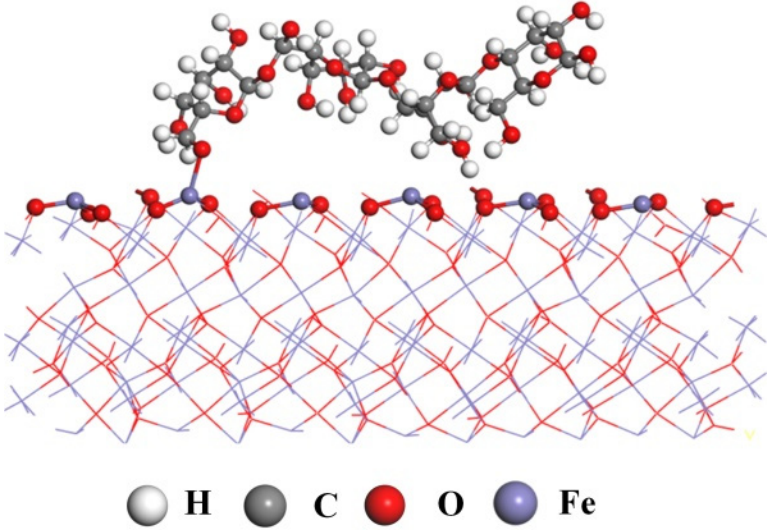
Figure 11. The pullulan adsorption model on hematite surface.